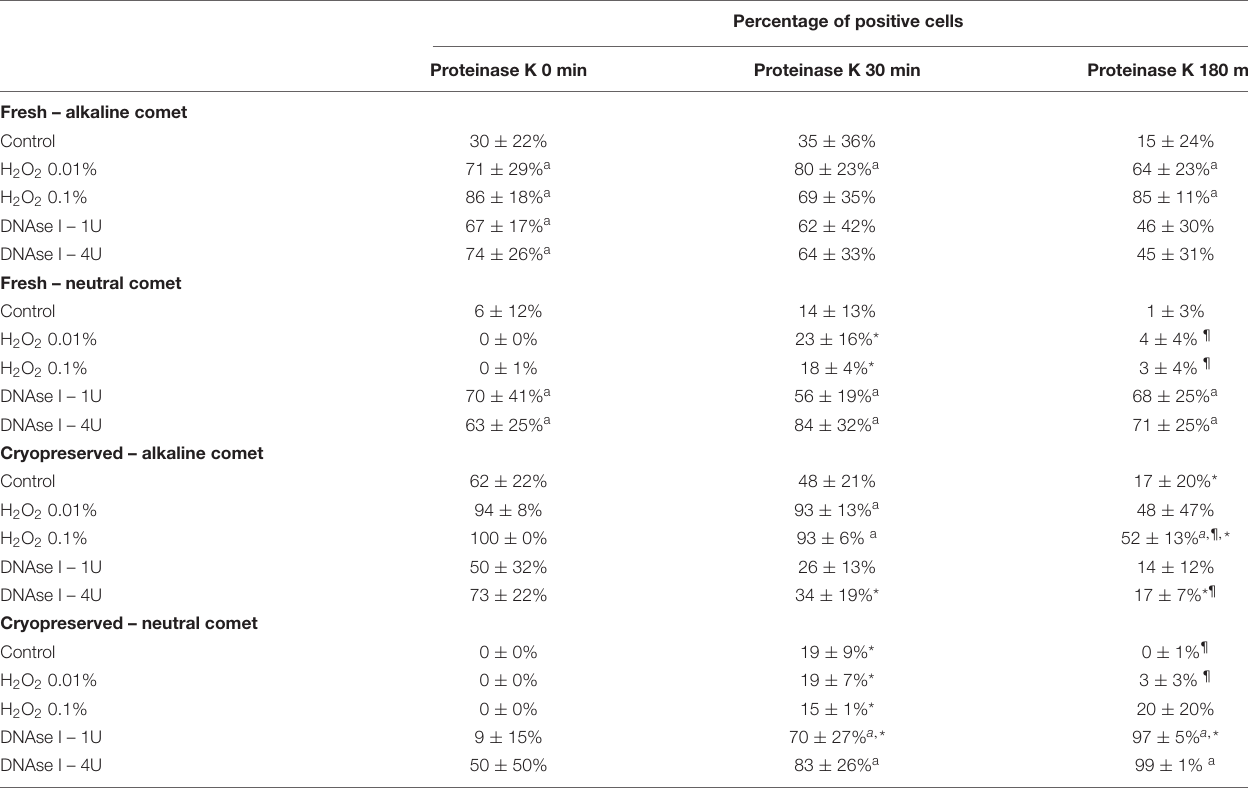
TABLE 3 | Percentage of sperm cells with DNA damage after hydrogen peroxide and DNAse treatments in different proteinase K